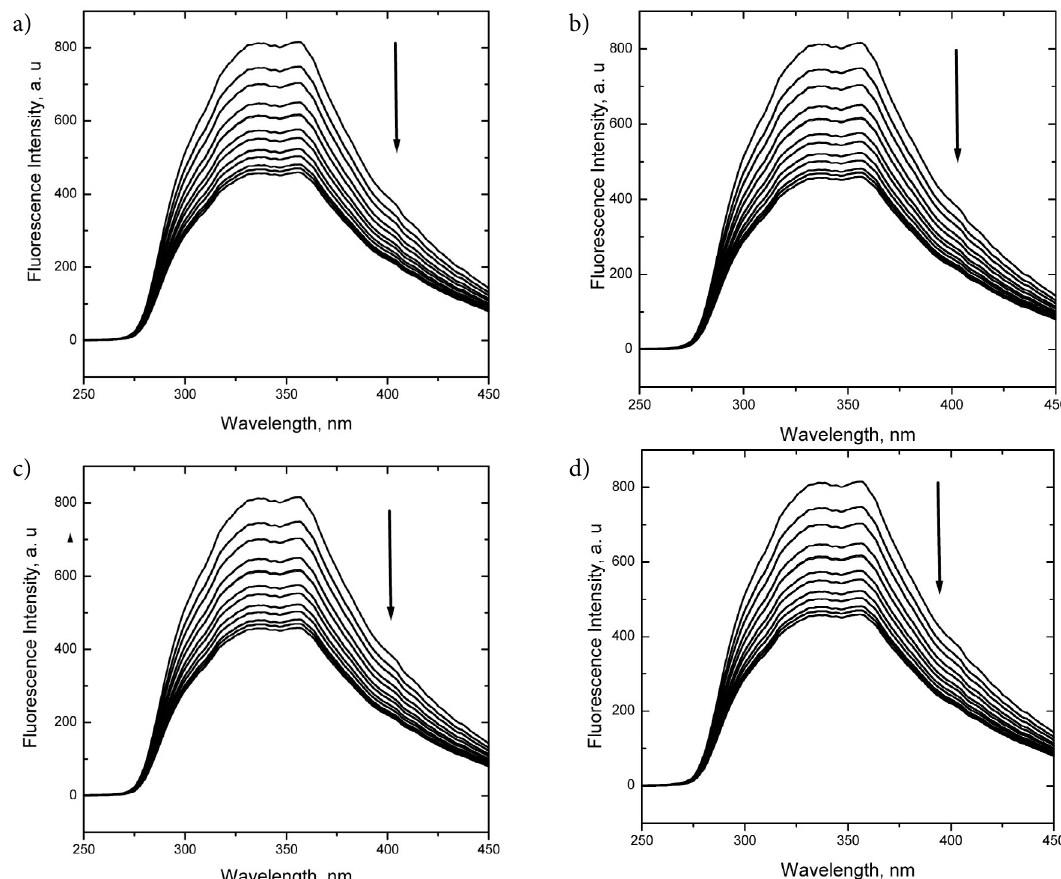
Figure 4. Fluorescence quenching spectra of human serum albumin at various concentrations of nandrolone dissolved in 2 % [BMIM] PF 6 ionic Liquid, [HSA] = 2 µM, [nandrolone] were: 0.00, 0.58, 1.15, 1.72, 2.28, 2.83. 3.37, 3.91, 4.44, 4.96, 5.48, 5.99 and 6.50 µM all in phosphate buffer solution 50 mM, 25 mM NaCl, pH = 7.0 at different temperatures: (a) 285K (b) 293 K (c) 303 K and (d) 310 K, λ ex = 280 nm. Table 1: Results of the binding in the nandrolone decanoate/ionic liquid/HSA systems.. Ionic